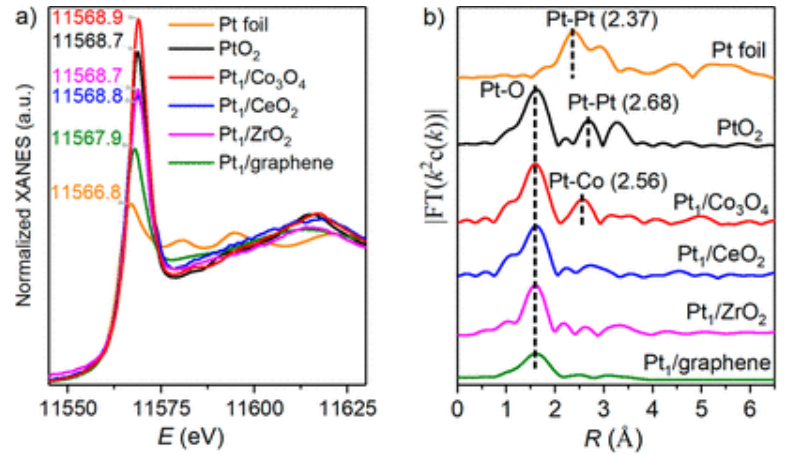
Figure 4. ( a ) XANES spectra of Pt1/Co 3 O 4 , Pt1/CeO 2 , Pt1/ZrO 2 , and Pt1/graphene single-atom catalysts as well as the Pt foil and PtO 2 reference at the Pt L3-edge. ( b ) The corresponding K2-weighted Fourier transform spectra. With permission from Ref [90], Copyright © 2019 American Chemical Society.